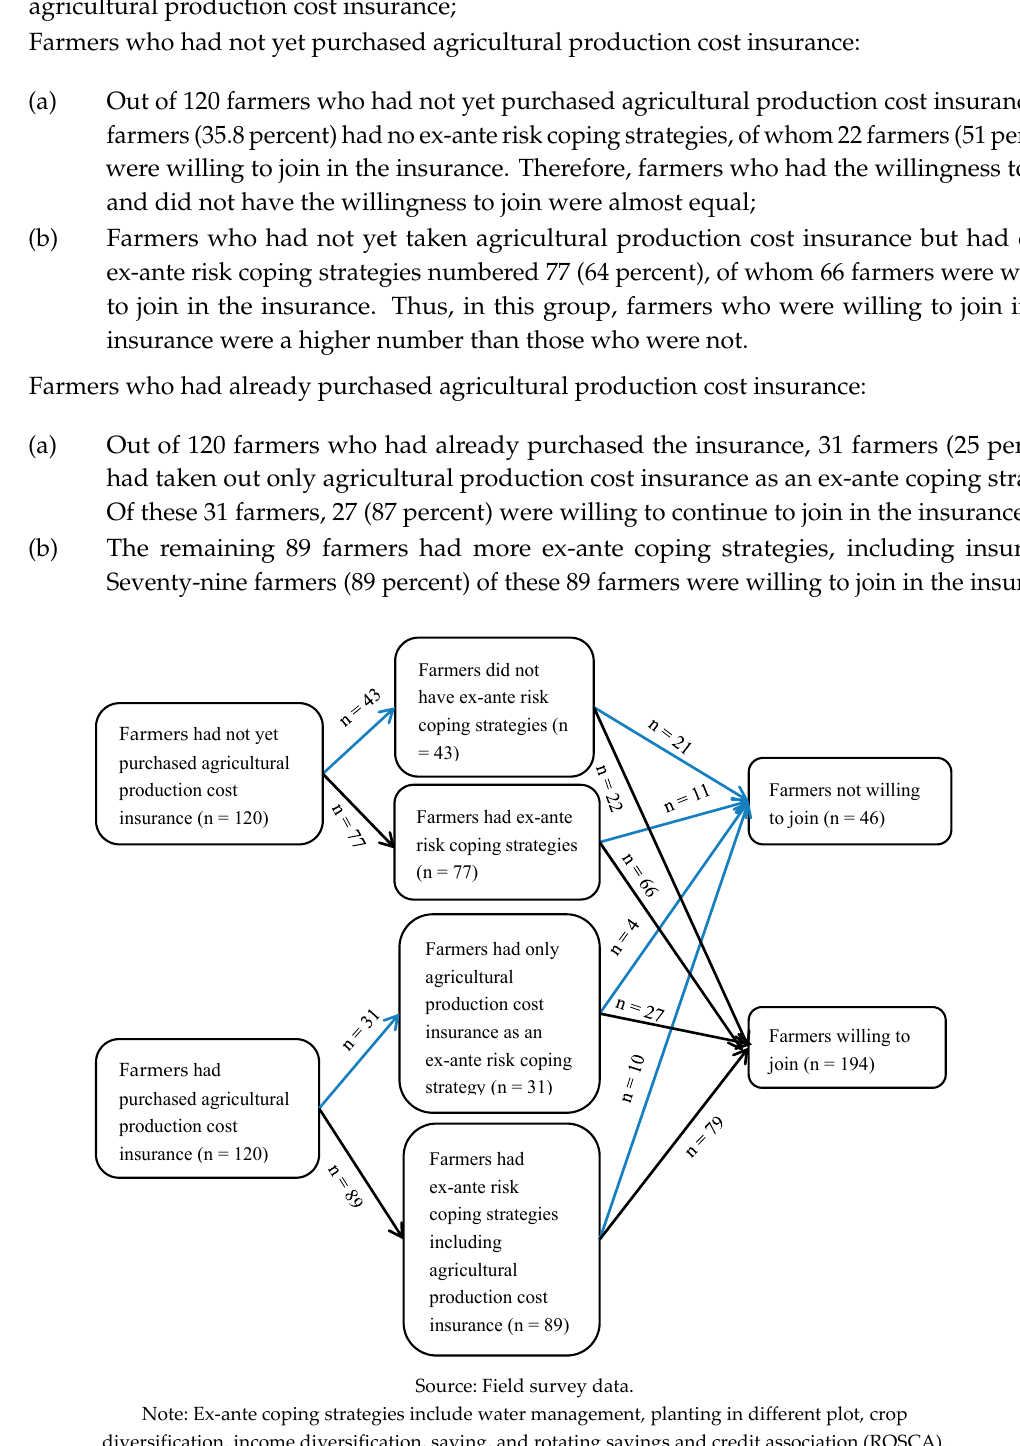
Figure 4. Pattern of farmers’ willingness to join.